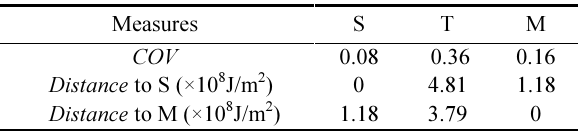
Table 4. Results (averaged) comparison for the annual Energy Use Intensity distributions Measures